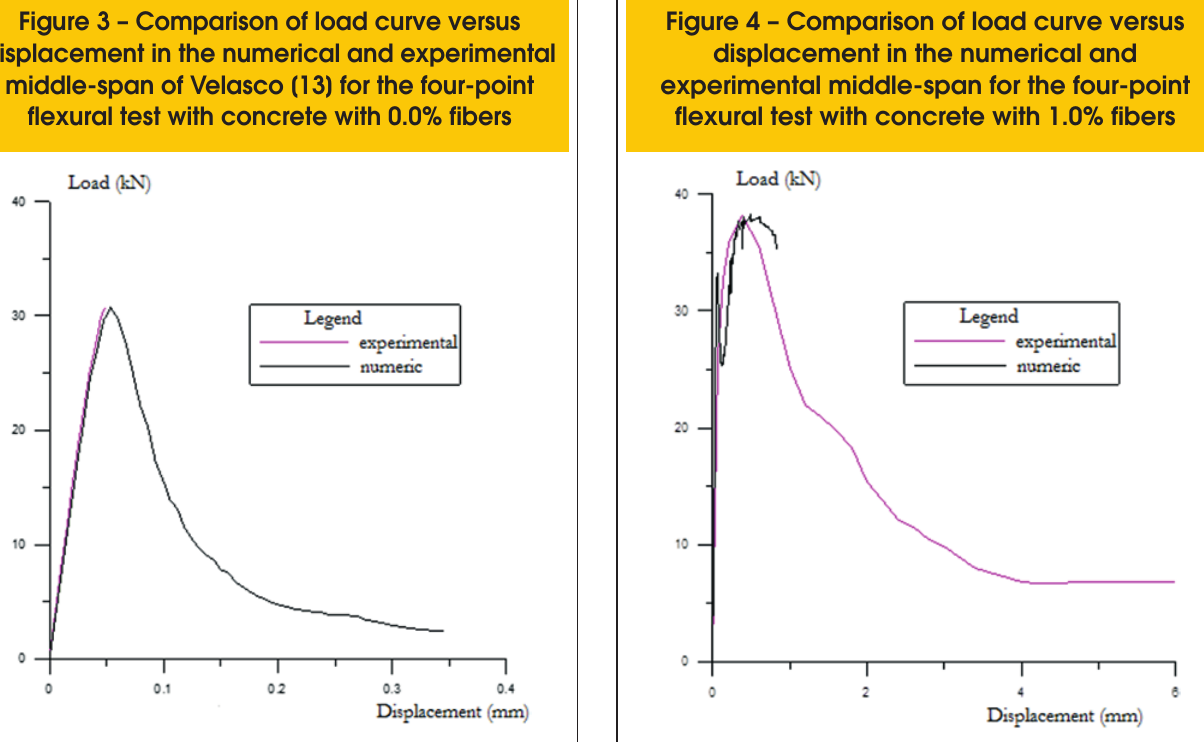
Figure 3 – Comparison of load curve versus displacement in the numerical and experimental middle-span of Velasco [13] for the four-point flexural test with concrete with 0.0% fibers